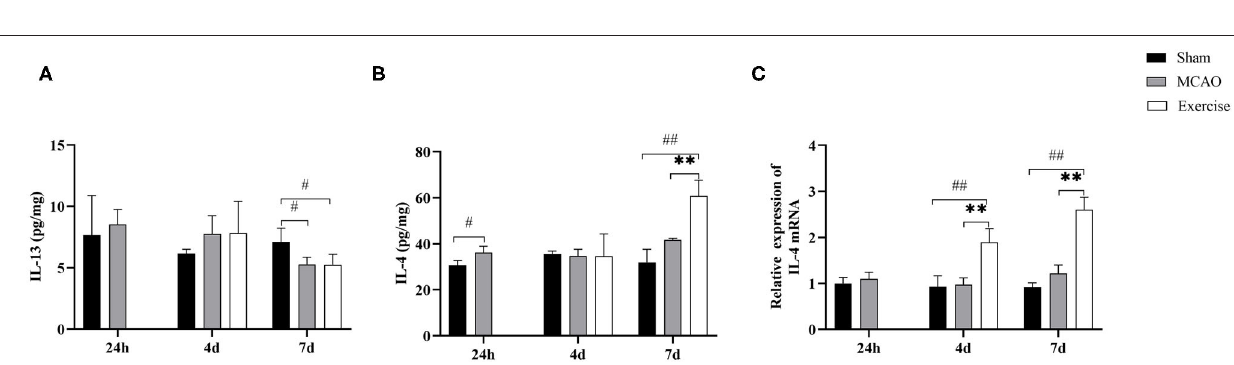
FIGURE 4 | Treadmill exercise altered the levels of M1/M2 markers. The levels of M1 markers, including (A) IL-1a, (B) IL-1b, (C) IL-6, (D) MCP-1, and M2 marker (E) IL-10 in the penumbra at 1-, 4-, and 7-days post-surgery among the sham, MCAO and exercise groups were examined by Luminex Multiplex Assays. Data are presented as the mean SD, n = 3/group. # P < 0.05, ## P < 0.01 vs. sham group; * P < 0.05, ** P < 0.01 vs. MCAO group.